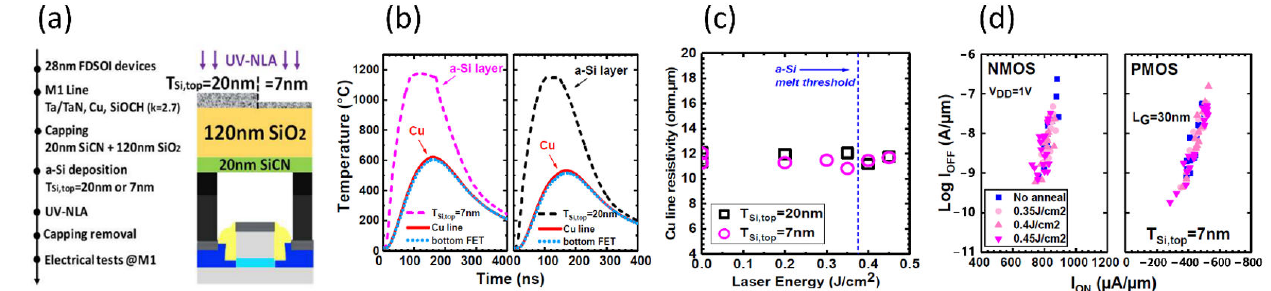
Figure 2. ( a ) Process flow and schematic figure of the 3D structure treated by UV-LA, ( b ) Simulated time–temperature profiles of the applied UV-LA processes, ( c ) Cu line resistivity evaluated before and after UV-LA, ( d ) I ON -I OFF distribution of the bottom n- and p-type MOS devices before and after UV-LA. Reprinted/adapted with permission from Ref. [4]. 2020